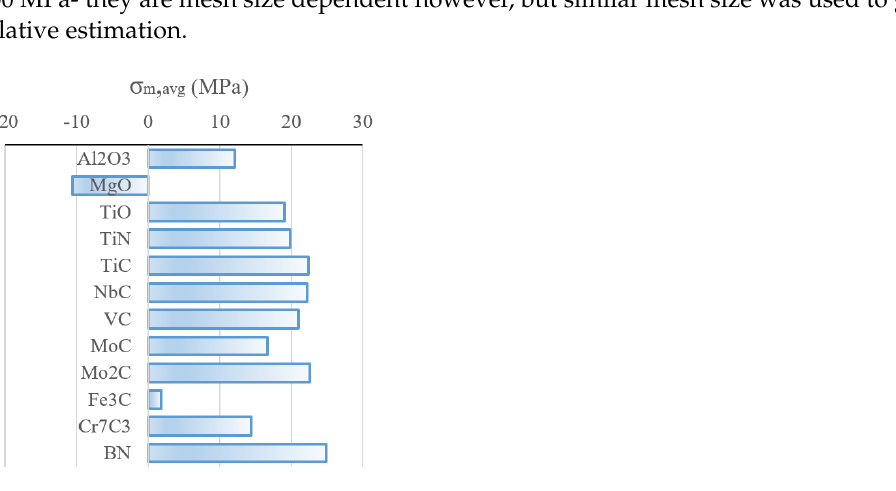
Figure 10. Residual stress formation potential in matrix for a precipitate volume fraction of ζ = 4% for relative comparison different inclusion types, after